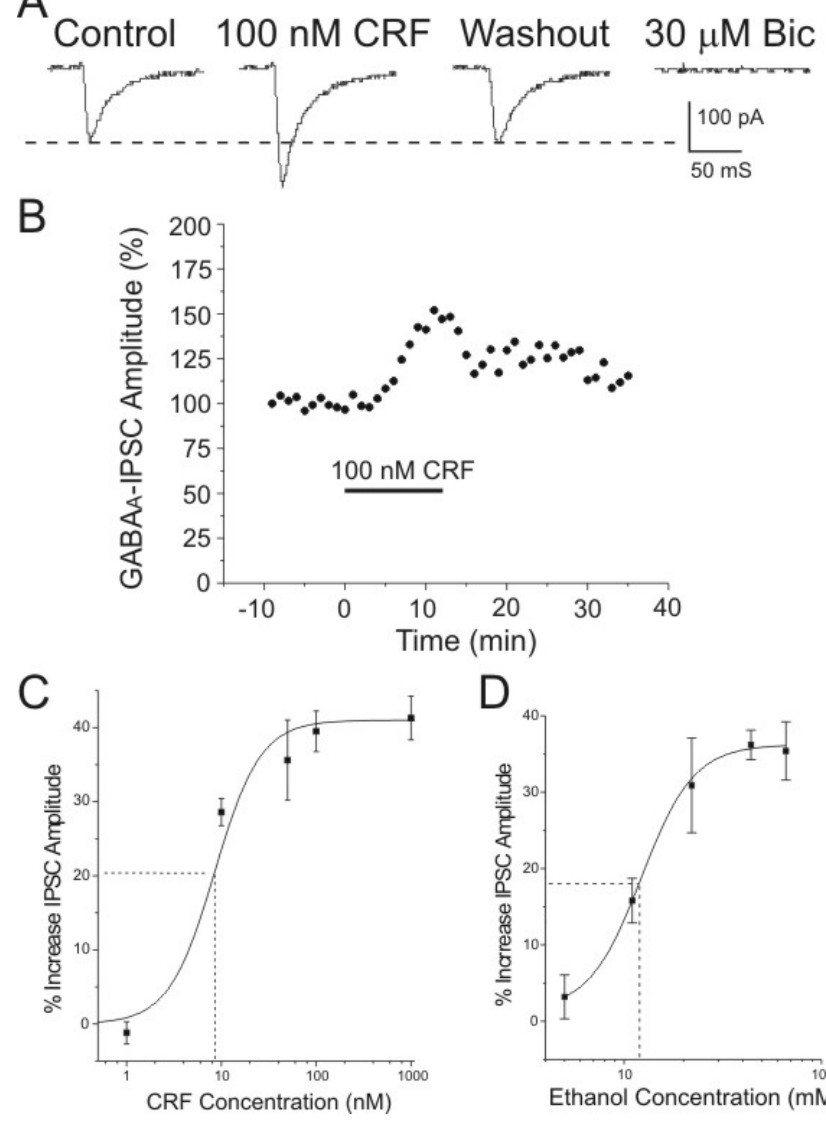
FIGURE 1. CRF response (A), time course of action (B), and concentration-response relationships for augmentation of IPSCs by CRF (C) and ethanol (D) superfused onto neurons in CeA slices from WT mice. (A) Representative effect of 100 n M CRF superfusion on IPSCs of a medial CeA neuron; note the augmentation of IPSC size by CRF, with the usual recovery on CRF washout. Subsequent bicuculline (Bic) superfusion totally blocks the IPSC, indicating mediation by GABA A receptors. (B) Time course of CRF action in another CeA neuron, showing a slow recovery from CRF after washout. (C and D) Pooled concentration-response data from five to eight neurons for each point. Points represent percent increase in mean (± SEM) IPSC peak amplitudes plotted against a log scale of drug concentrations. Solid curves are logistic fits of the data plotted by Origin software (ver. 7, OriginLab Corp, Northampton, MA), using y = (A1 – A2)/[1 + (x/xo)p + A2], where A1 is the initial value of IPSC increase (0–1%), A2 the estimated final maximum value (41% for CRF, 36% for ethanol), xo is the center x (8.5 for CRF; 12.3 m M for ethanol) value (unfixed), and p is the rate or power (1.8 for CRF; 3.3 for ethanol). All values were fixed except rate/power. Dashed lines indicate the apparent EC 50 for each agent: 9 n M for CRF and 12 m M for ethanol. Note the similar maximal effect of both agents. Values for the ethanol concentration-response curve taken from the dataset reported in Nie et